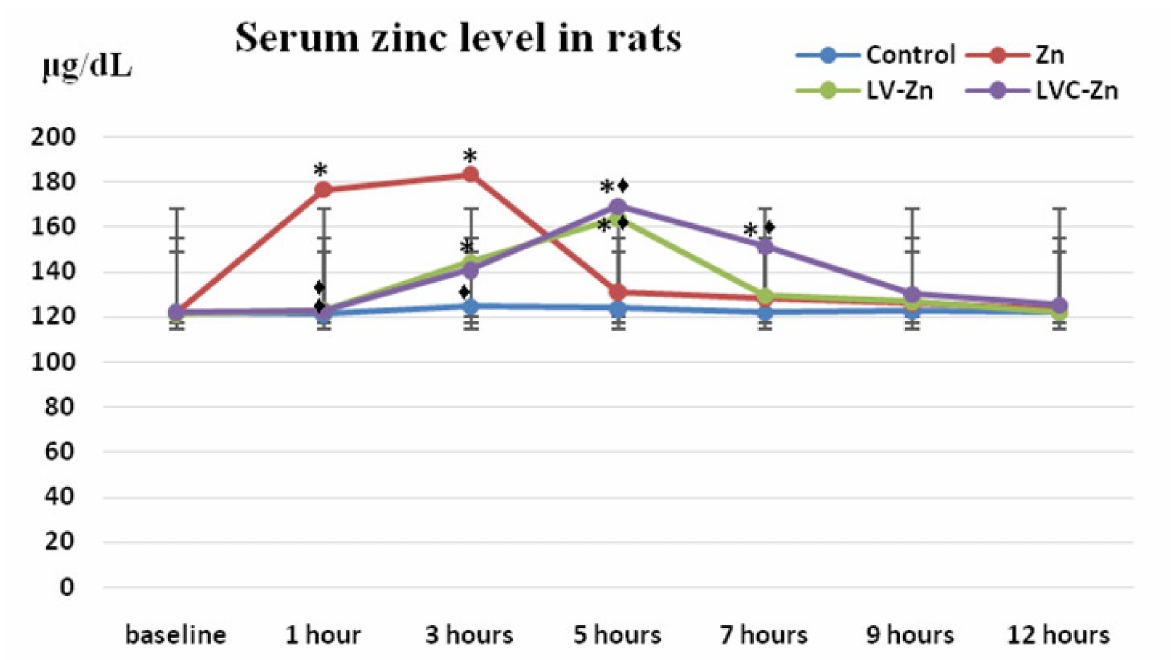
Figure 6. Variation of serum Zn levels after the administration of LV-Zn and LVC-Zn in rats; * p < 0.01 vs. baseline; (cid:7) p < 0.01 vs.